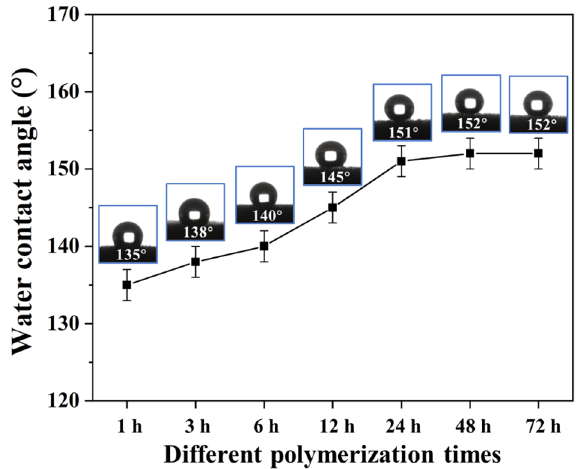
Figure 11. The WCAs of OTS-PDA-MS with different polymerization time in PDA suspension.